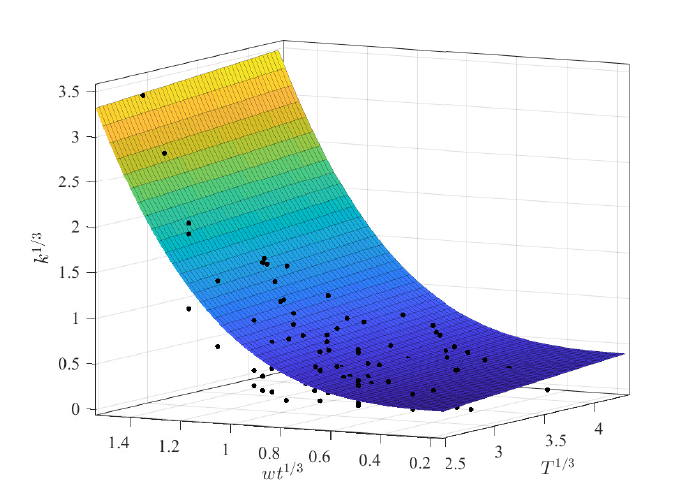
Figure 6. Best fitting results for the CMC dataset with k 1/3 as a function of wt 1/3 and T 1/3 .